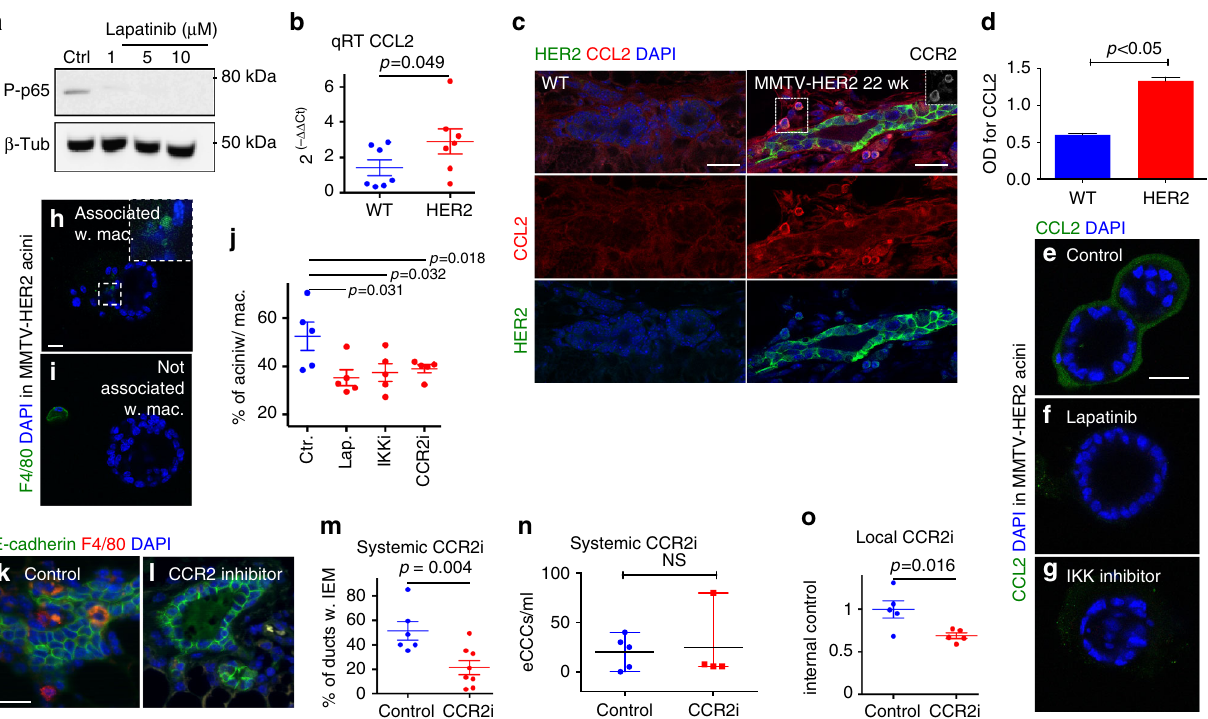
Fig. 6 HER2 activates NF- κ B and upregulates CCL2. a Western blot for NF- κ B subunit phospho-p65 in mammosphere (MS) lysates from 20-week-old MMTV-HER2 mice. One representative blot of three independent experiments is shown. b CCL2 expression in MS from FVB wild-type and pre-malignant MMTV-HER2 mammary glands (MGs). Technical replicates, three experiments (3 mice/group); statistical analysis: with 95% con fi dence interval by Mann – Whitney test. c MGs from FVB wild-type and 22-week-old MMTV-HER2 mice stained against CCL2, HER2, and CCR2. Bars: 25 μ m. Inset, CCR2 signal, zoom factor 1x; full image in Supplementary Fig. 5i. CCL2 intensity was quanti fi ed using ROI tool in Metamorph (Supplementary Fig. 5h). d ELISA of CCL2 in 24 h conditioned media of WT or HER2 + MS isolated from two animals. P value with 95% con fi dence interval by Mann – Whitney test — SEM shown. e – g CCL2 staining in acini cultures from MMTV-HER2 MGs (20 – 24 weeks (wks)) grown for 5 days and then DMSO-treated (vehicle